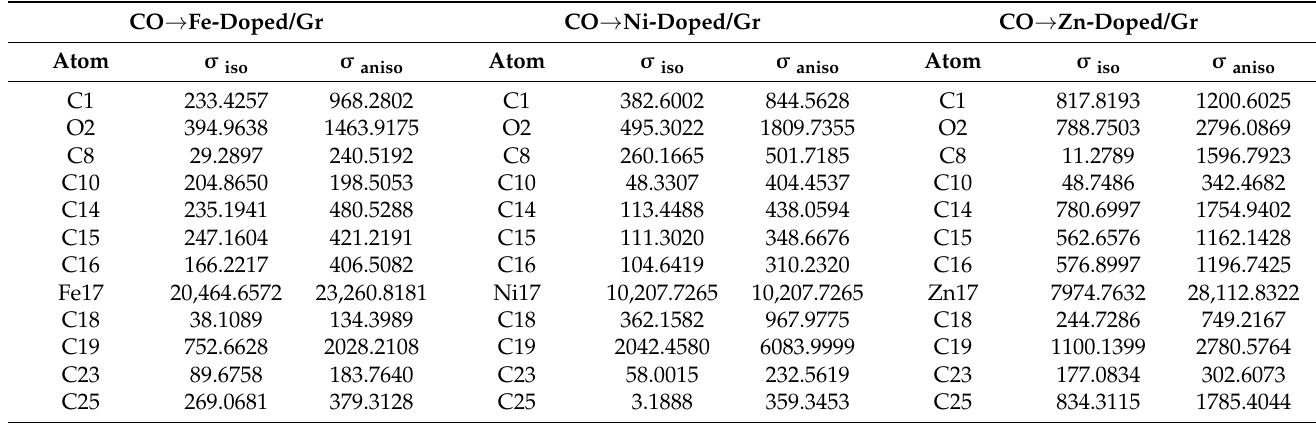
Table 1. Calculated NMR chemical shielding tensors for some atoms in the active site of CO